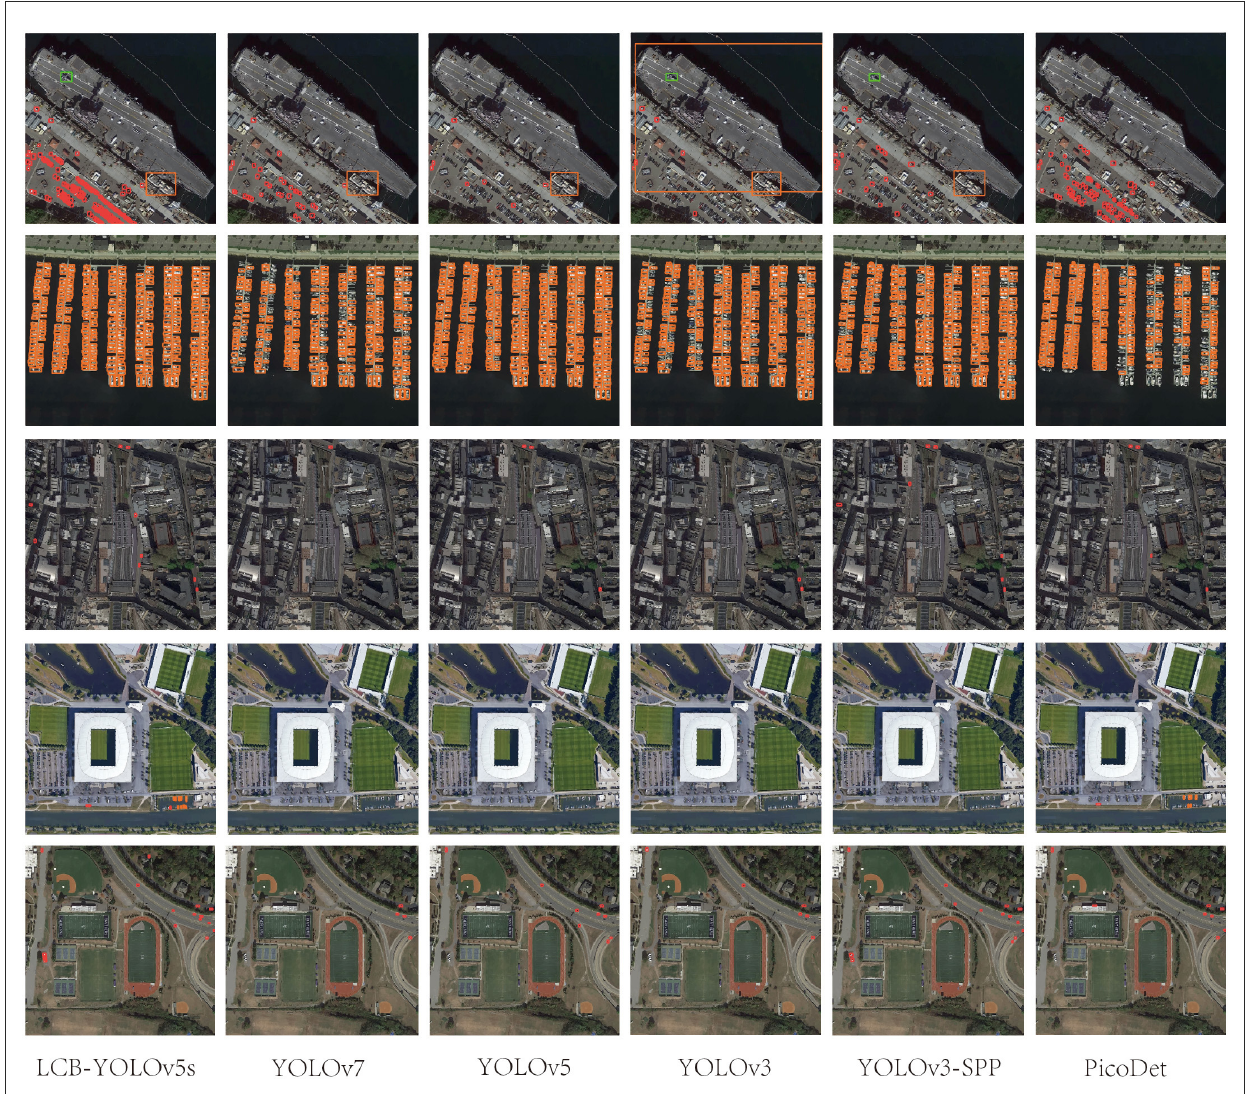
FIGURE13 Comparison of the target detection of six different models on the DIOR-VAS